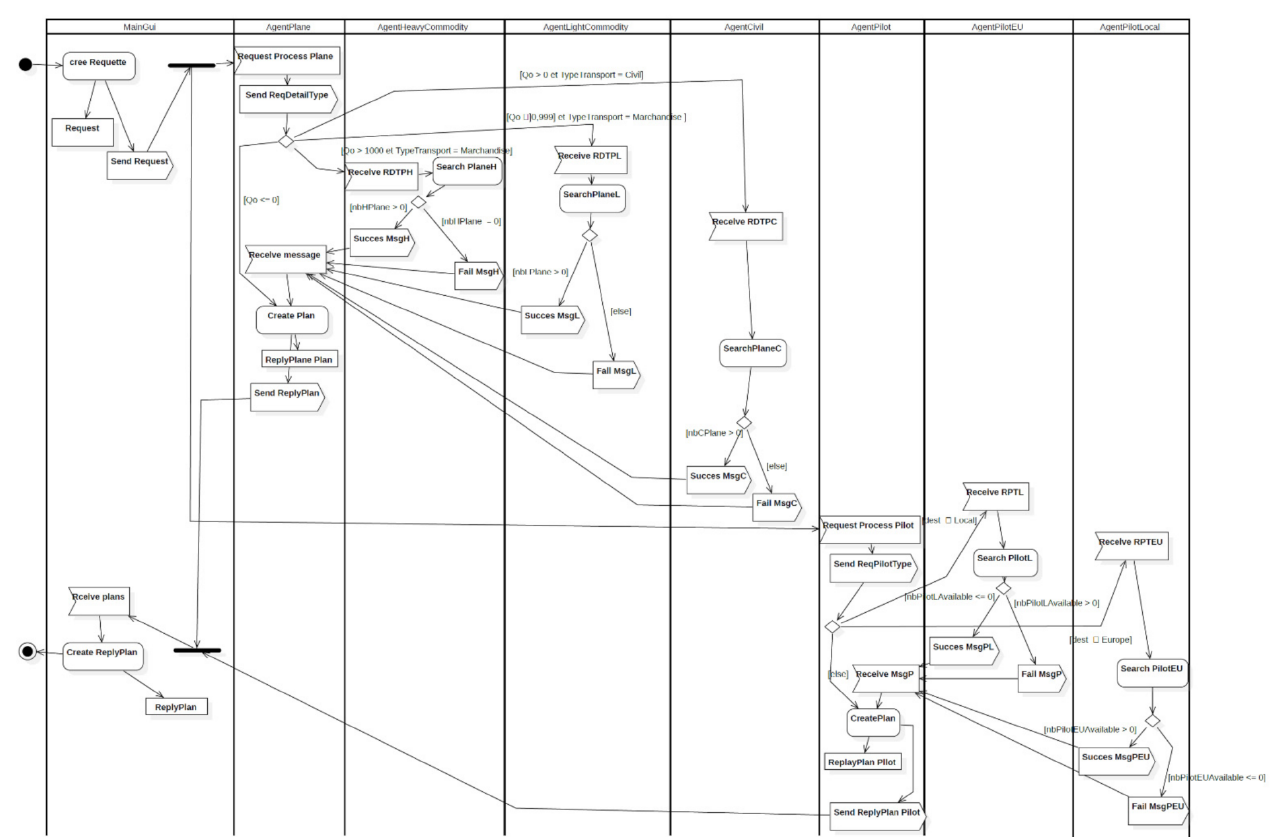
Figure 5. Activity diagram.